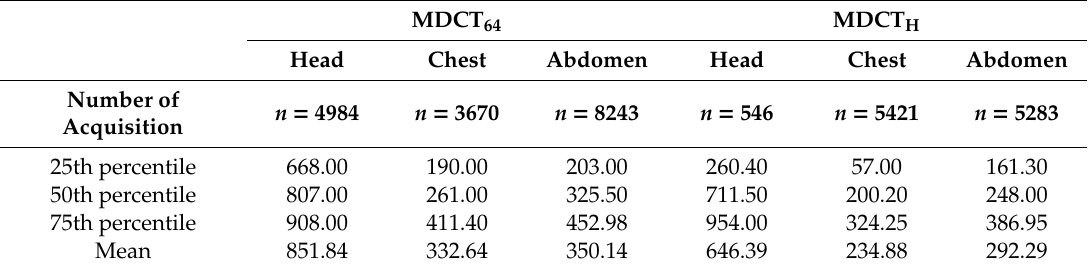
Table 2. Dose-length product (DLP) (mGy-cm) from consecutive adult CT examinations. MDCT 64